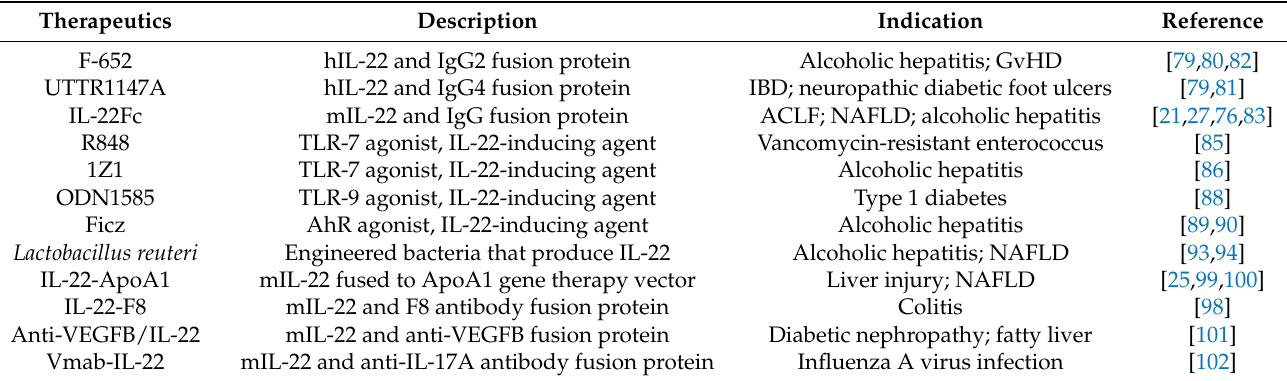
Table 1. Therapeutic applications of IL-22 for human